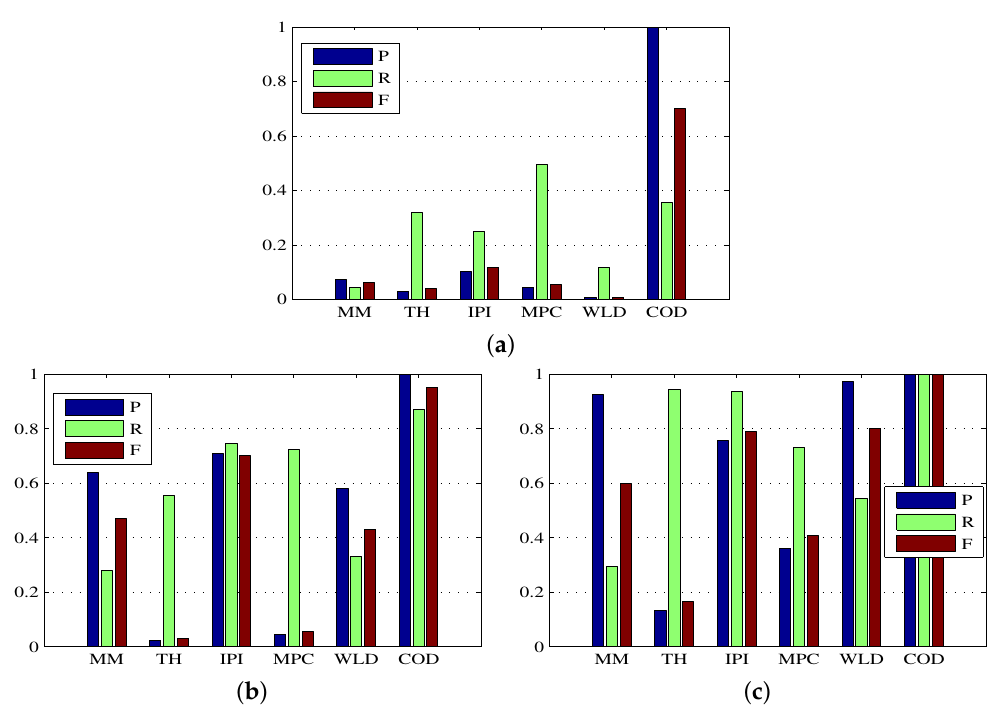
Figure 8. Precision, recall, and F-measure bars for the proposed method and other existing methods. ( a – c ) denote the results of the proposed method and other existing methods on Sequence 1, Sequences 2 and Sequence 3